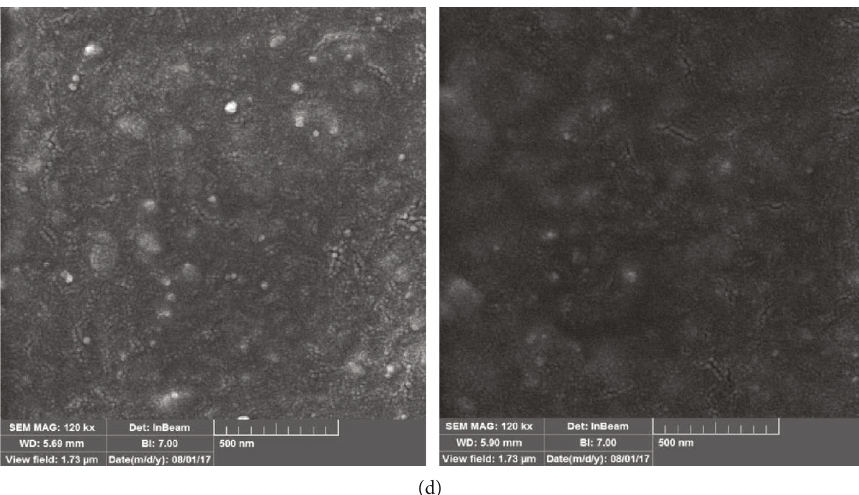
Figure 5: SEM images of: (a) S-SBR, (b) Si69-SSBR, (c) T-SBR, and (d) A-SSBR at two magni fi cations of × 50,000 and × 120,000